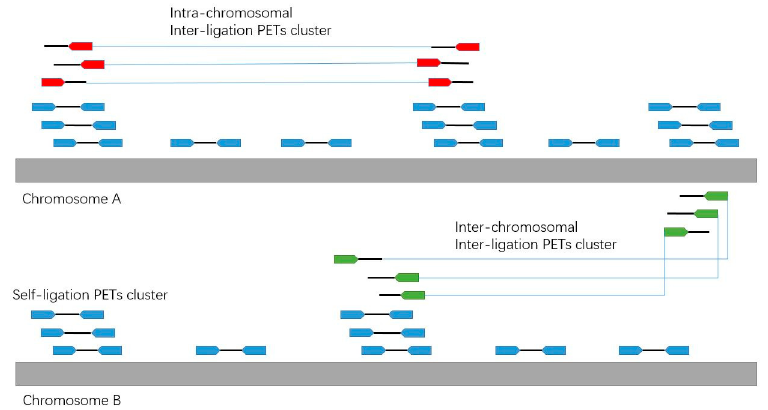
Figure 6. Illustration of the different categories of PETs.